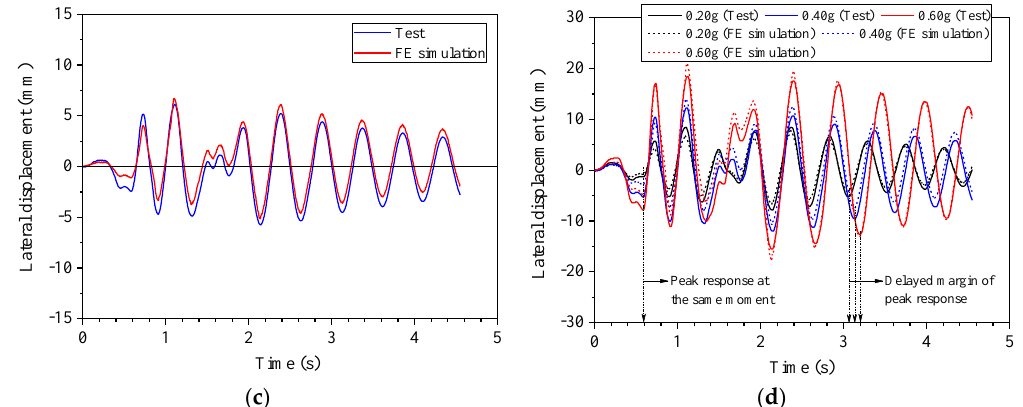
Figure 11. Comparison of time-history lateral displacement responses between the FE simulation and test results: ( a ) Top of A-shaped frame under 0.40 g; ( b ) Middle part of truss under 0.40 g; ( c ) Middle part of column under 0.40 g; ( d ) Top of A-shaped frame under 0.20 g, 0.40 g and 0.60 g.